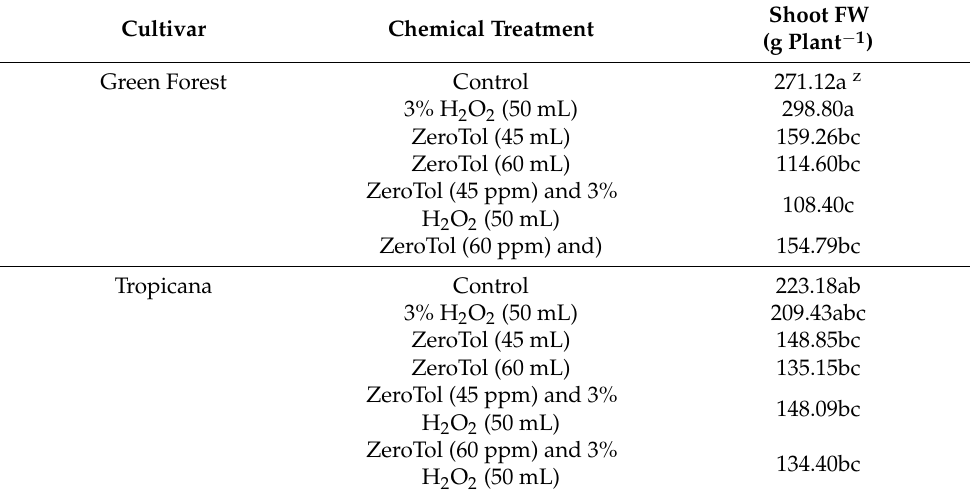
Table 2. Least square means interaction between lettuce cultivars and hydrogen peroxide treatment for shoot fresh weight of two cultivars (‘Green Forest’ and ‘Tropicana’) grown in ebb and flow hydroponic systems for 30 days after transplanting at OSU research greenhouses in Stillwater, OK. Experiment one.